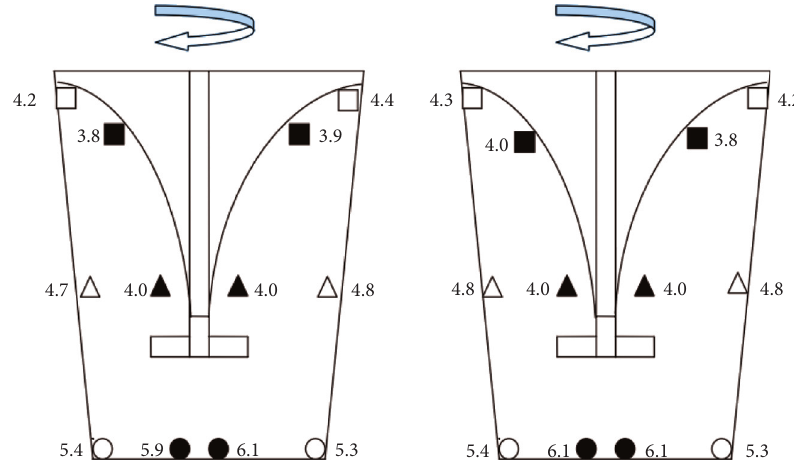
Figure 5: Clockwise rotation of the stirrer [50].